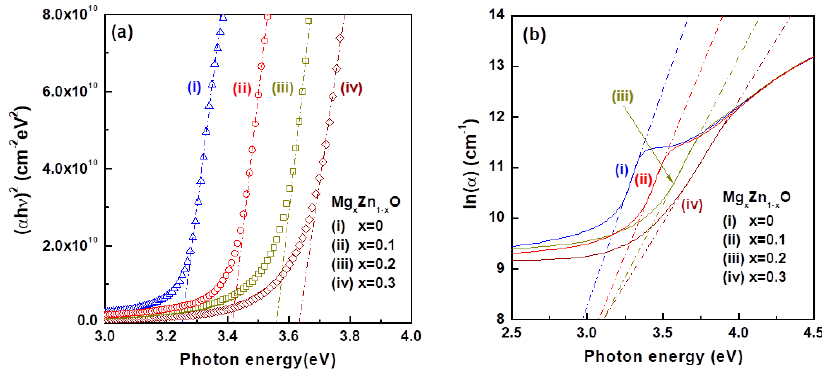
Figure 5. ( a ) Plot of ( α h ν ) 2 versus photon energy (h ν ) and ( b ) plot of ln( α ) versus photon energy (h ν ) of Mg x Zn 1 − x O thin films.